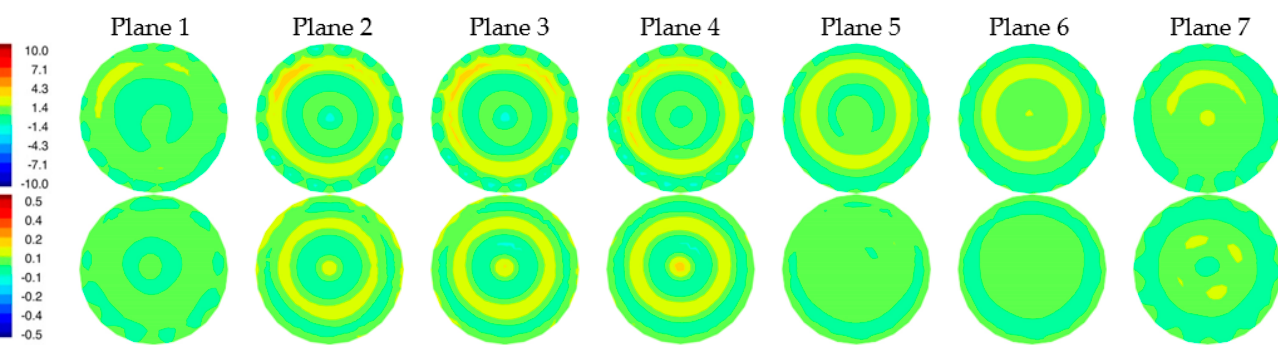
Figure 8. Reconstructed 2D 1300 MHz permittivity ( top ) and conductivity ( bottom ) images for all seven planes of the simulated breast phantom for the cases with ( a ) and without ( b ) the skin layer, respectively.